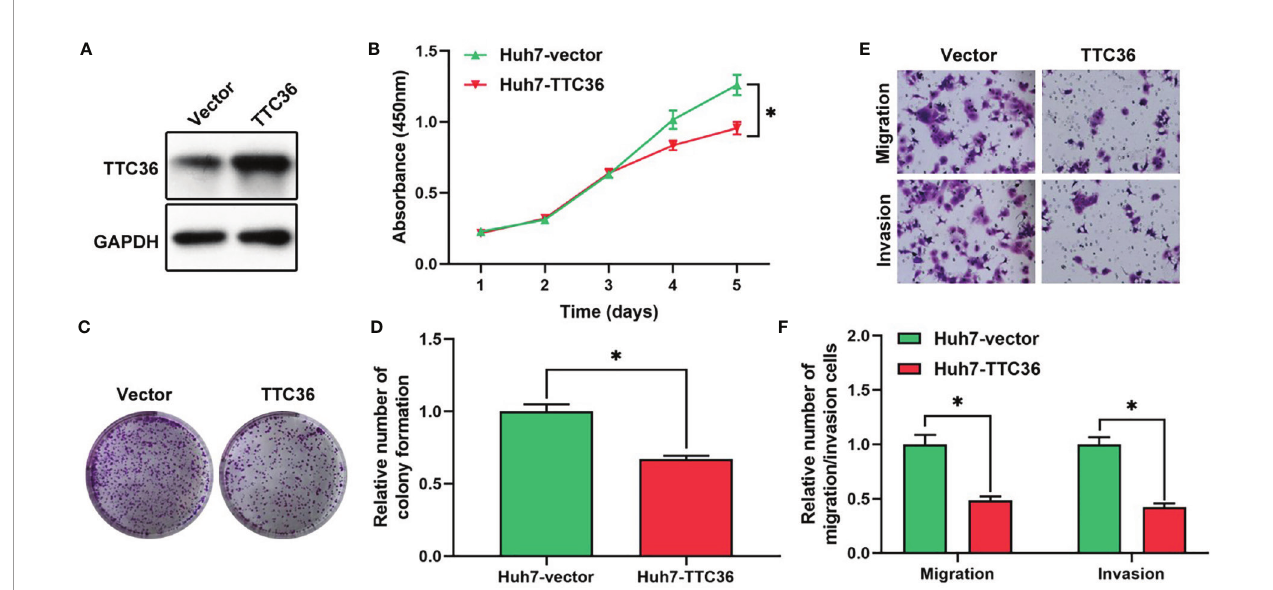
FIGURE 5 | Validation of the role of TTC36 in human liver cancer. (A) The ef fi cacy of TTC36 ectopic expression is determined in hepatocellular carcinoma (HCC) cells. (B) Cell proliferation was assessed with the CCK-8 assay in Huh7 cells. (C, D) The effect of TTC36 overexpression on colony formation was counted in Huh7 cells. (E, F) Representative images and histogram analysis of the Transwell migration and invasion assays after TTC36 upregulation in Huh7 cells. * p -value<0.05.